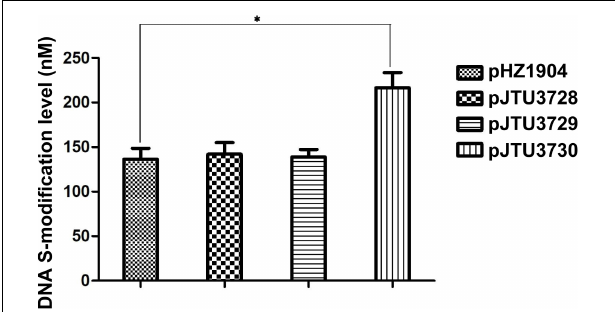
FIGURE 4 | The effect of mutation in S9 and S12 sulfur-modified sites on DNA sulfur modification level. pHZ1904 and its derivatives were transferred into HXY6 through conjugation, and DNA sulfur modification abundance for each strain was compared. pJTU3728, pHZ1904 derivative with single mutation in S9 site; pJTU3729, pHZ1904 derivative with single mutation in S12 site; pJTU3730, pHZ1904 derivative with double mutations in S9 and S12 sites. ∗ P < 0.05. Three replicates were